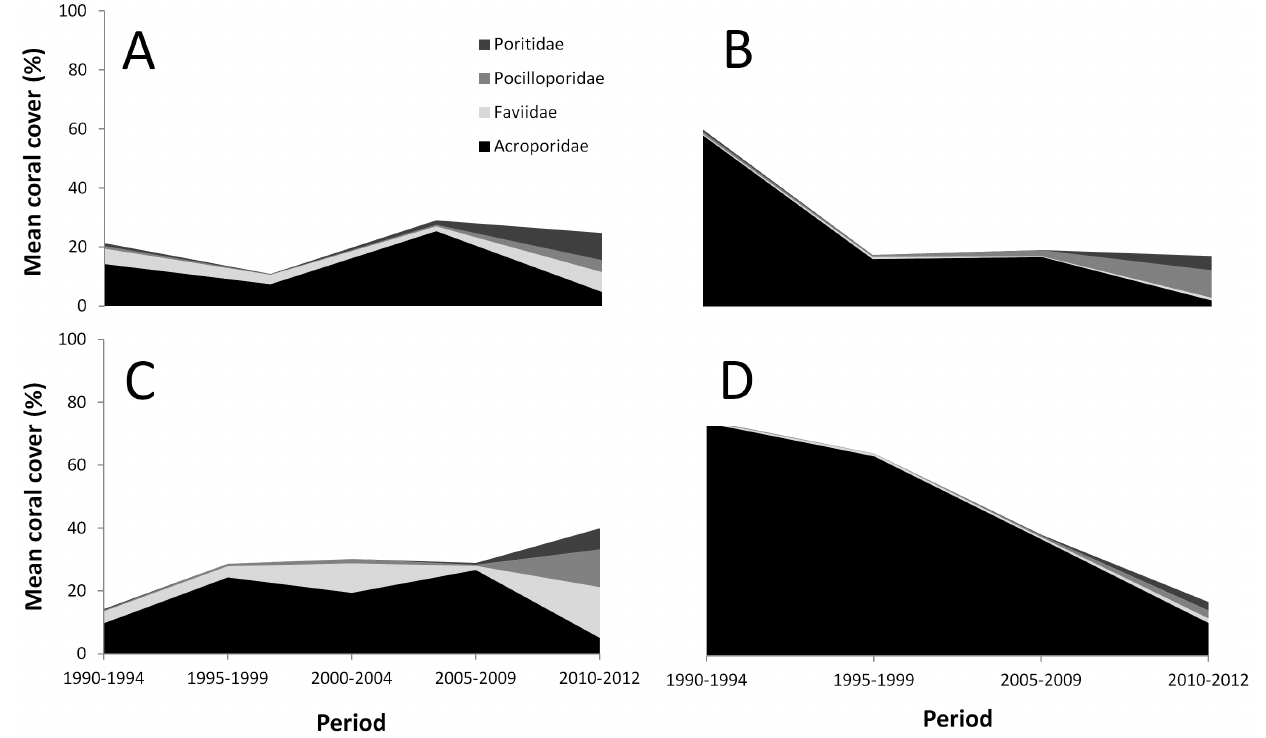
Figure 5. Coral community composition at Ningaloo Reef. A) North, B) North-east, C) Central, and D) South.